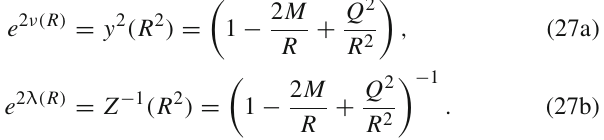
Fig. 1 Radial pressure p r against radial distance r